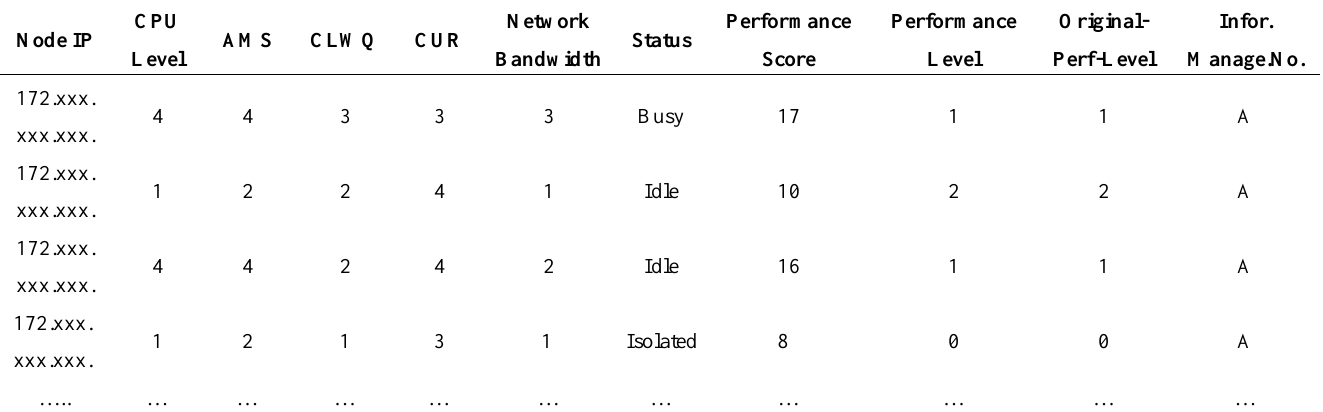
Table 1. An example of the performance